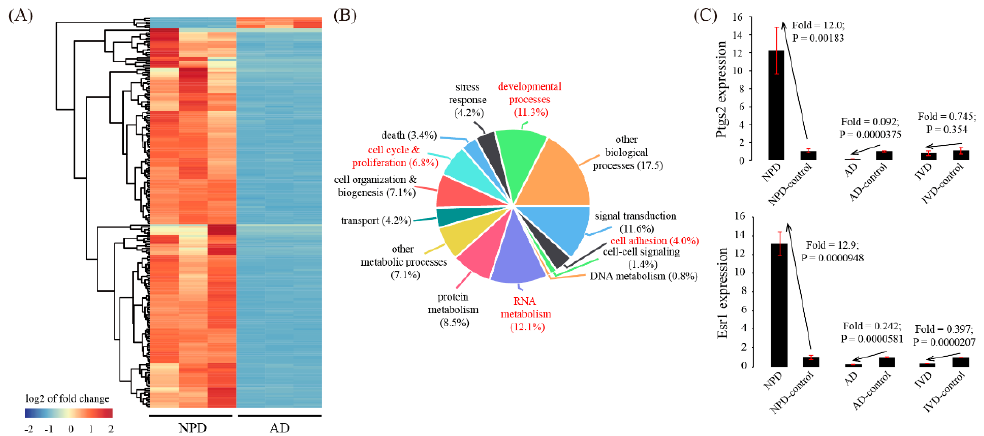
Figure 5. Identification of inconsistently expressed genes in the AD model compared to the NPD model. ( A ) Cluster dendrogram of inconsistently expressed genes. The average linkage clustering algorithm with the Pearson correlation distance measure was used. ( B ) GO enrichment analysis of inconsistently expressed genes. ( C ) Validation of representative inconsistently expressed genes by using qRT-PCR. Data were plotted as mean ± SEM. n = 3.